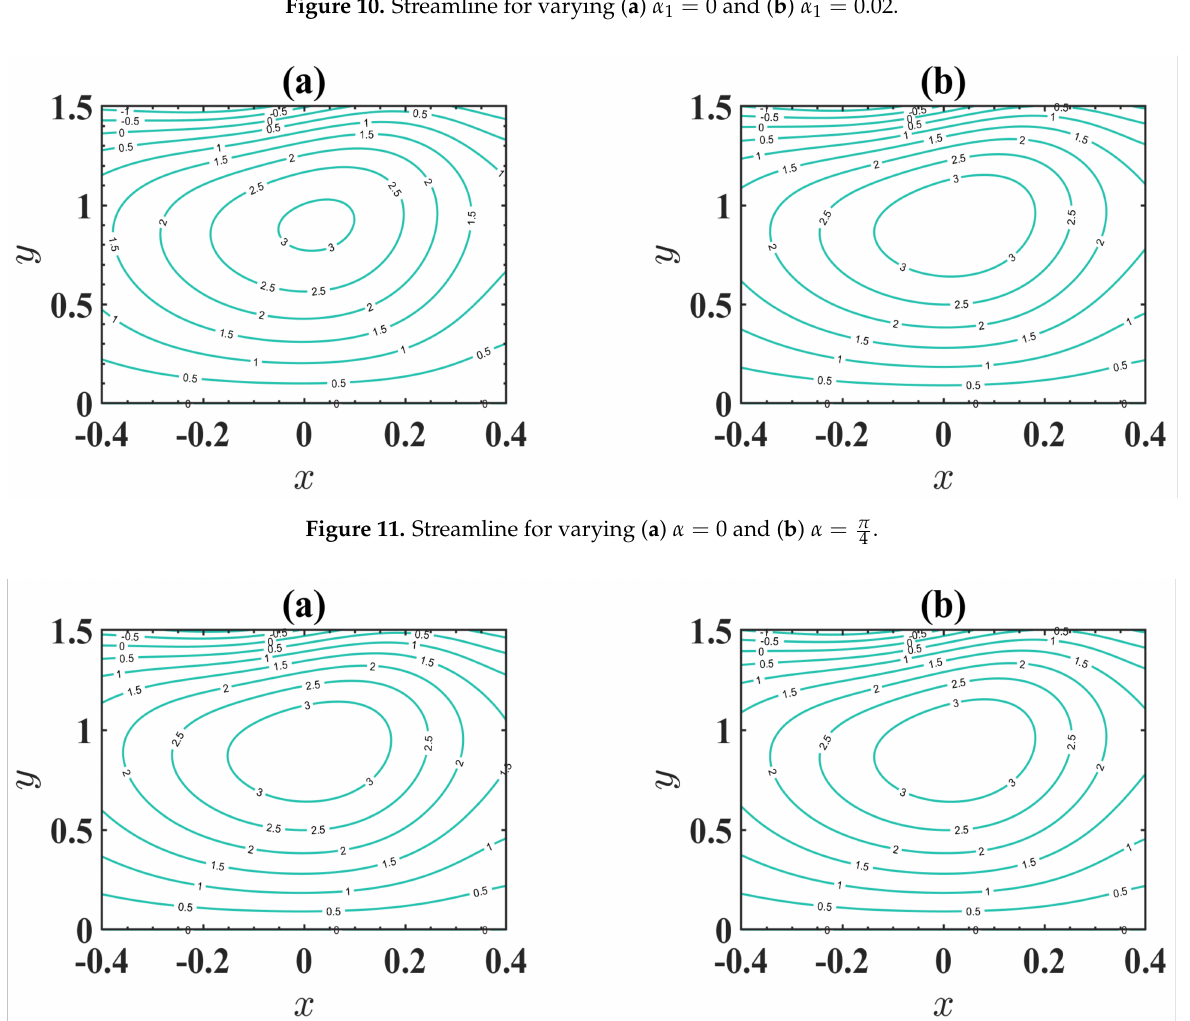
Figure 12. Streamlines for ( a ) m 1 = 0 and ( b ) m 1 =